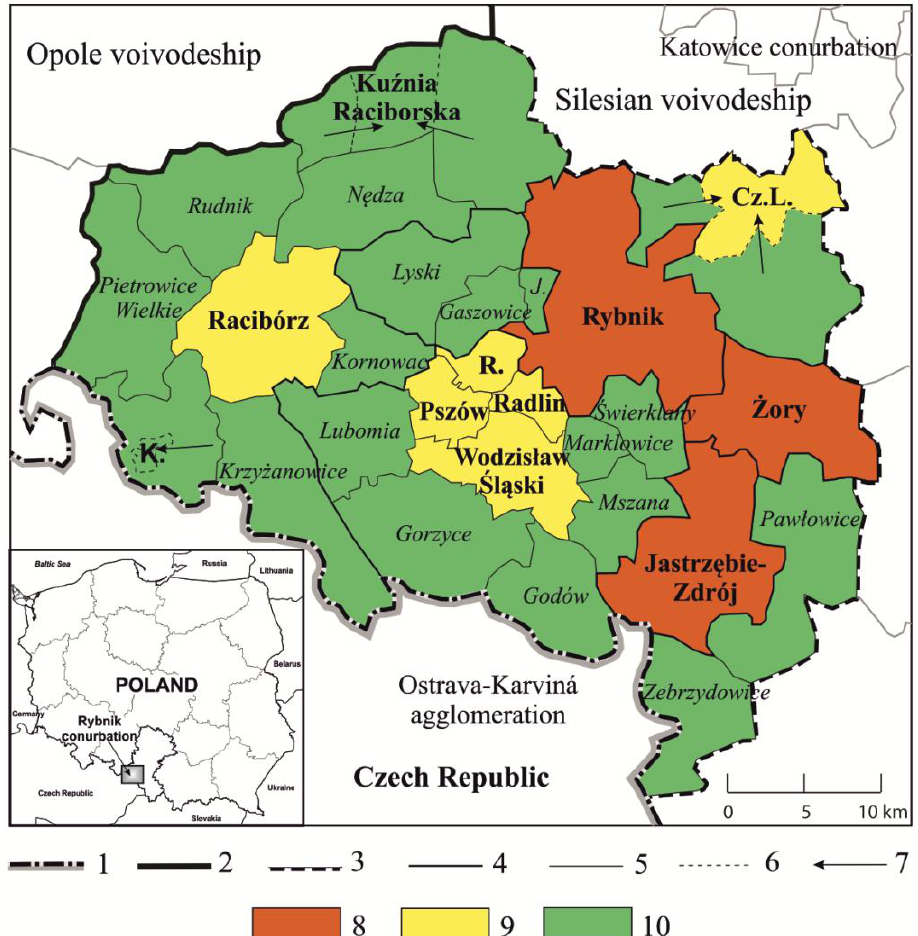
Fig. 1. The area of the Rybnik conurbation (authors elaboration based on the Krzysztofik, 2007, 2008) 1 – border of country; 2 – border of voivodeship (province); 3 – border of the Rybnik conurbation; 4 – border of district; 5 – border of administrative unit (community); 6 – border of towns localized inside of urban-rural unit; 7 – directions of administrative hierarchy inside administrative units; 8 – core of the Rybnik conurbation; 9 – internal zone of conurbation; 10 – external zone of conurbation; Racibórz – urban unit (town); Gorzyce – rural unit; Cz.L. – Czerwionka-Leszczyny; K. – Krzanowice; R. – Rydułtowy; J. –